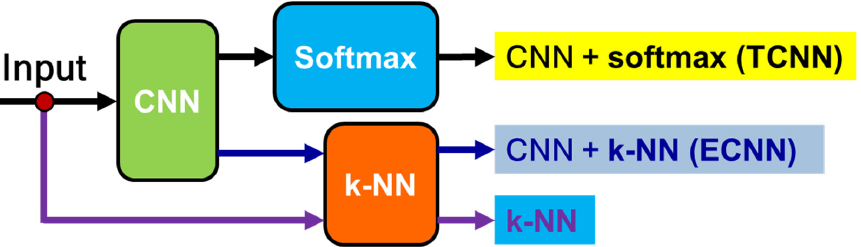
Figure 13. Scheme of the three configurations for improving accuracy.